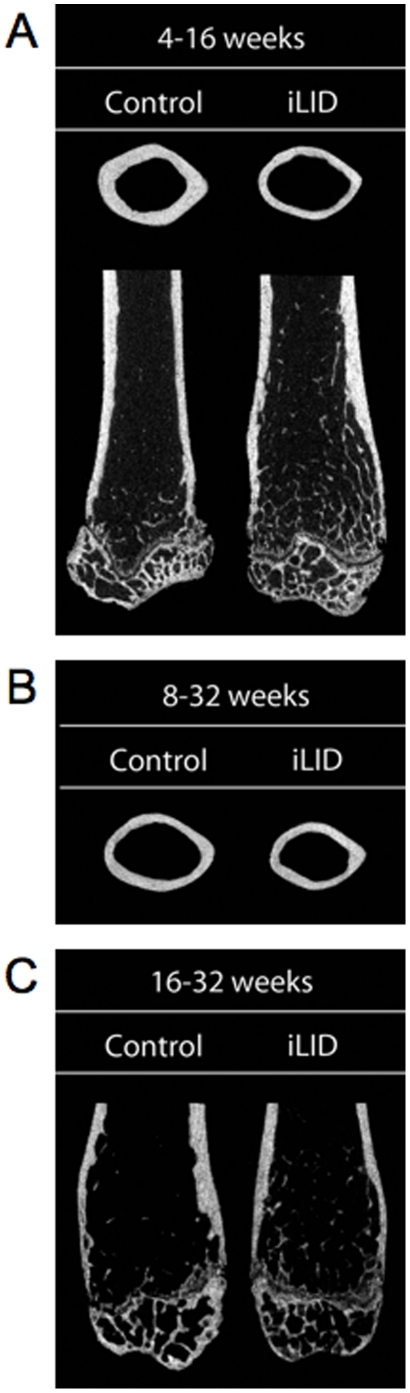
Micro-CT images of control and iLID mice indicating differences in cortical and trabecular bone accrual.(A) Mice injected with tamoxifen at 4 weeks and sacrificed at 16 weeks. (B) Mice injected with tamoxifen at 8 weeks and sacrificed at 32 weeks. (C) Mice injected with tamoxifen at 16 weeks and sacrificed at 32 weeks.